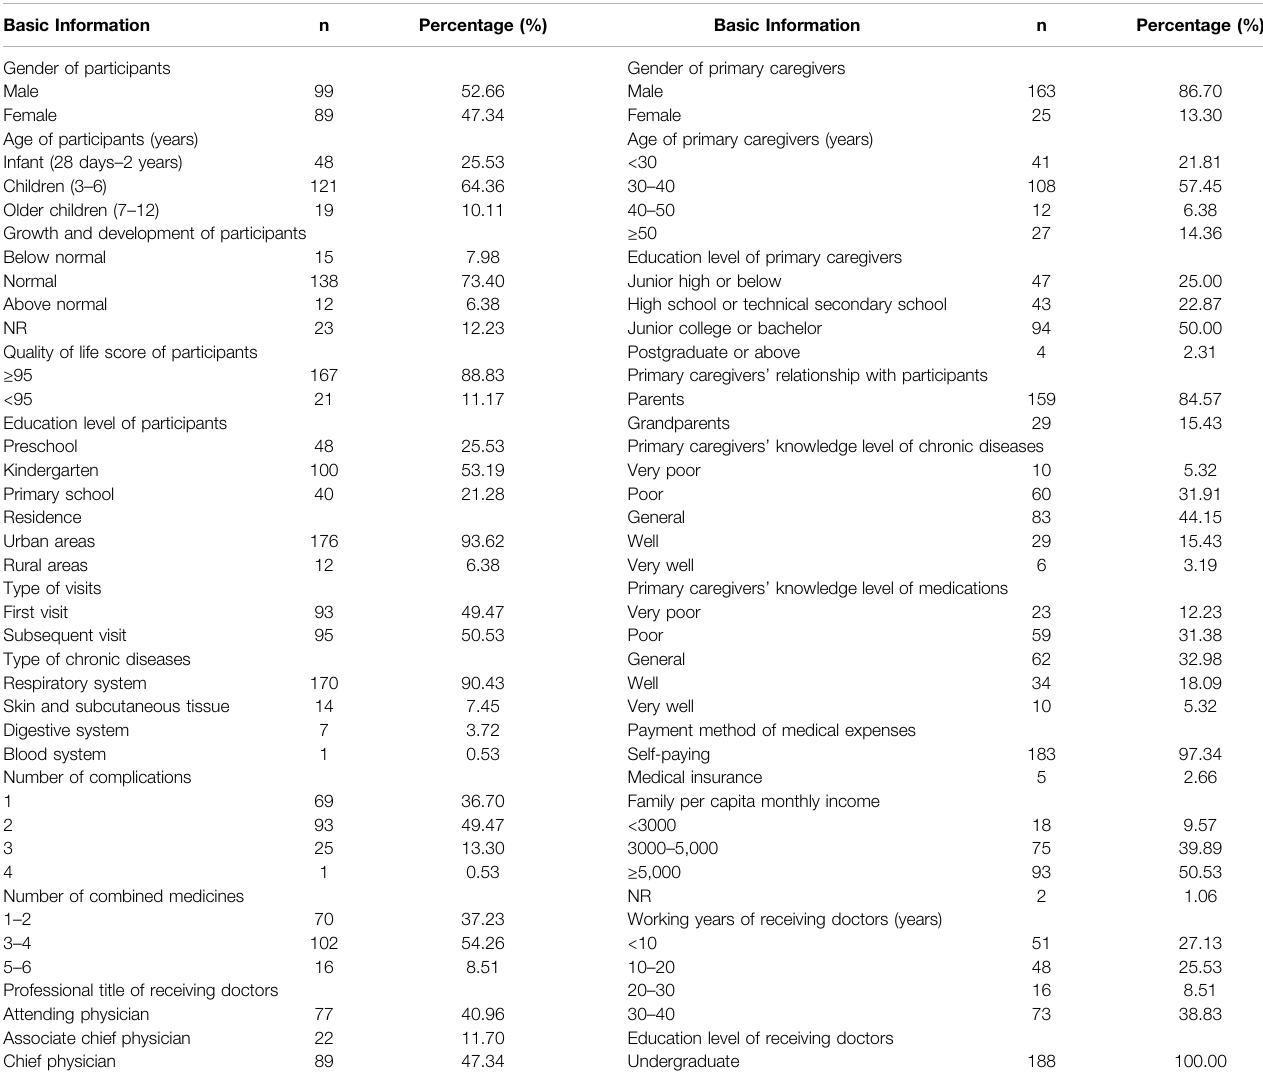
TABLE 1 | Basic information of the participants, primary caregivers, and receiving doctors. Basic